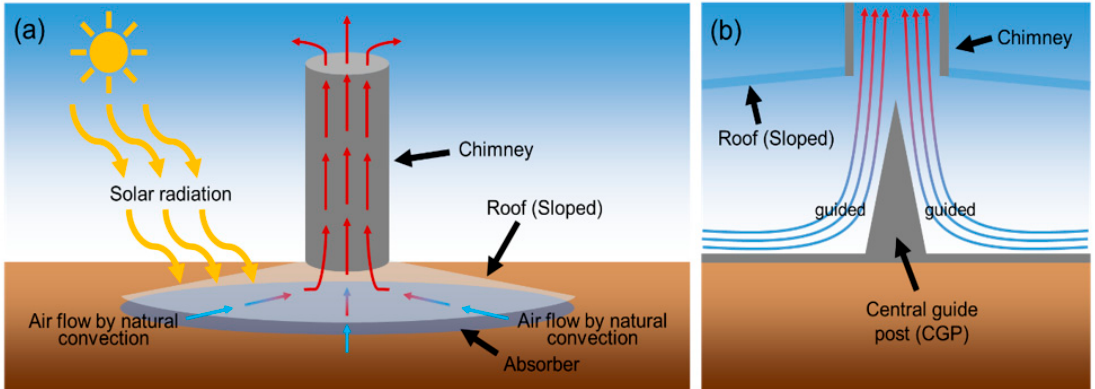
Figure 1. Schematic diagrams showing the effects of the central guide post (CGP) in a solar updraft tower (SUT) system. ( a ) Basic principles describing the natural convection occurring inside the SUT. ( b ) Guided updraft flow by CGP in the SUT.